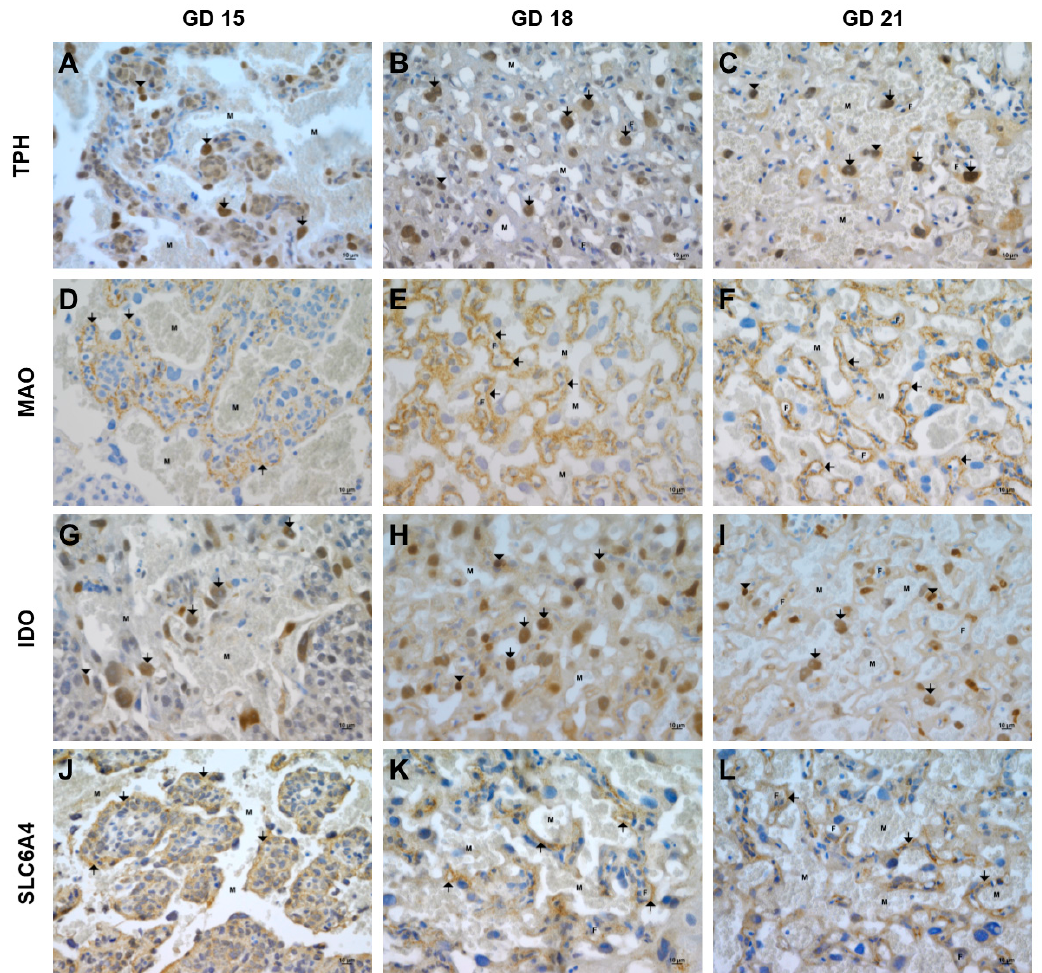
Figure 4. Immunohistochemical staining of TPH, MAO, IDO, and SLC6A4 in the rat placenta during gestation. TPH expression was detected in the labyrinth zone in cytotrophoblast cells (arrows) and fetal capillaries (arrowheads) at GD 15 ( A ), 18 ( B ), and 21 ( C ). MAO expression was only detected in the area of the labyrinth zone in cytotrophoblast/syncytiotrophoblast cells (arrows) at GD 15 ( D ) and 18 ( E ) and predominantly in the inner layers of the syncytiotrophoblast (layer II and III) at GD 21 ( F ). The most significant reactivity for IDO was visible in the labyrinth zone in cytotrophoblast cells (arrows) and fetal endothelial cells (arrowheads) at GD 15 ( G ), 18 ( H ), and 21 ( I ). Weak SLC6A4 expression was detected in cytotrophoblast/syncytiotrophoblast cells (arrows) in the placental labyrinth at GD 15 ( J ) and 18 ( K ), whereas at GD 21 ( L ), positivity was visible in the inner layers of the syncytiotrophoblast (layer II and III). M, maternal compartment, and F, fetal compartment. Bar: 10 µm.